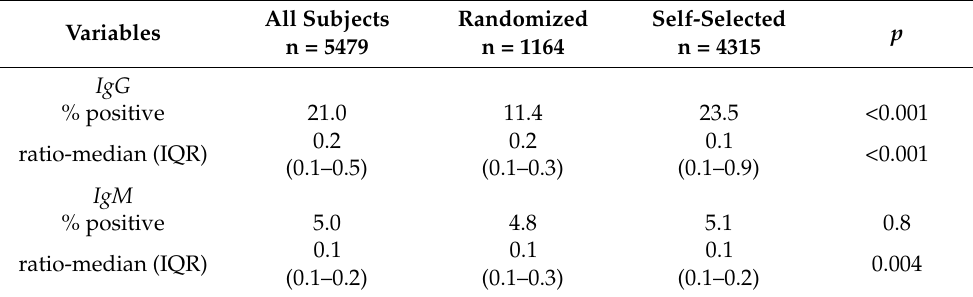
Table 4. The prevalence of positive serological results and ratios of IgG and IgM: percentages or median values with interquartile ranges (IQR).